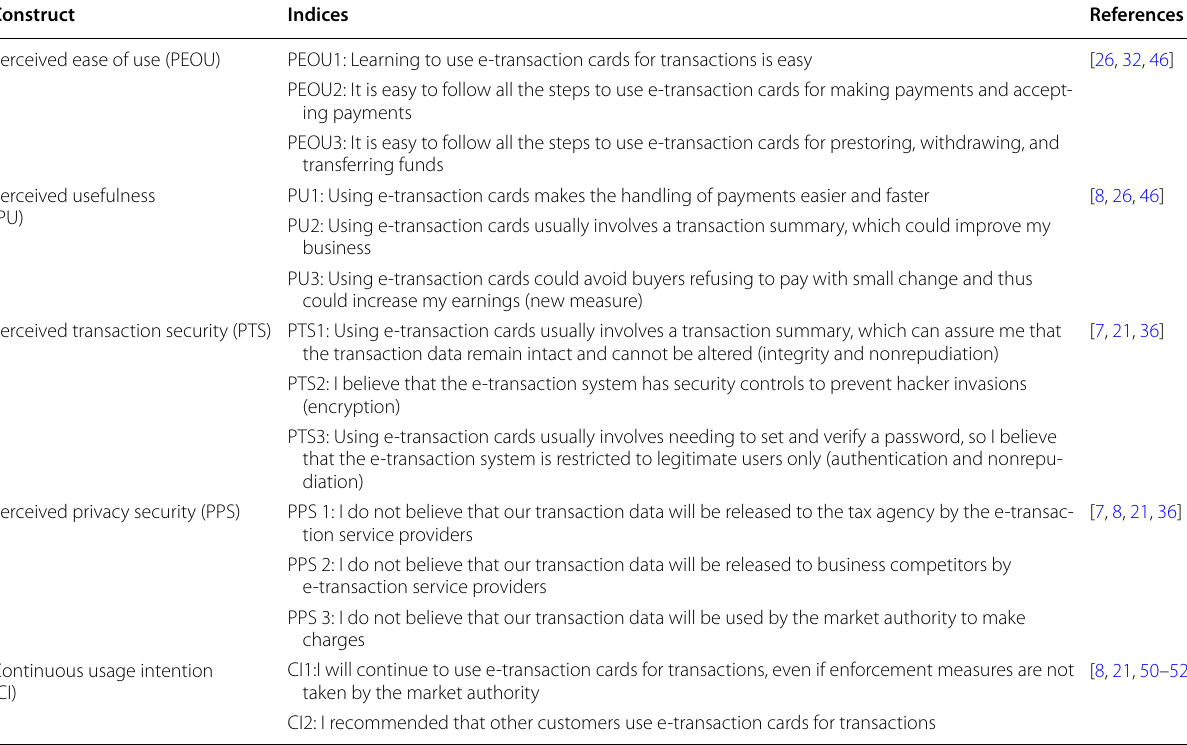
Table 2 Measurement